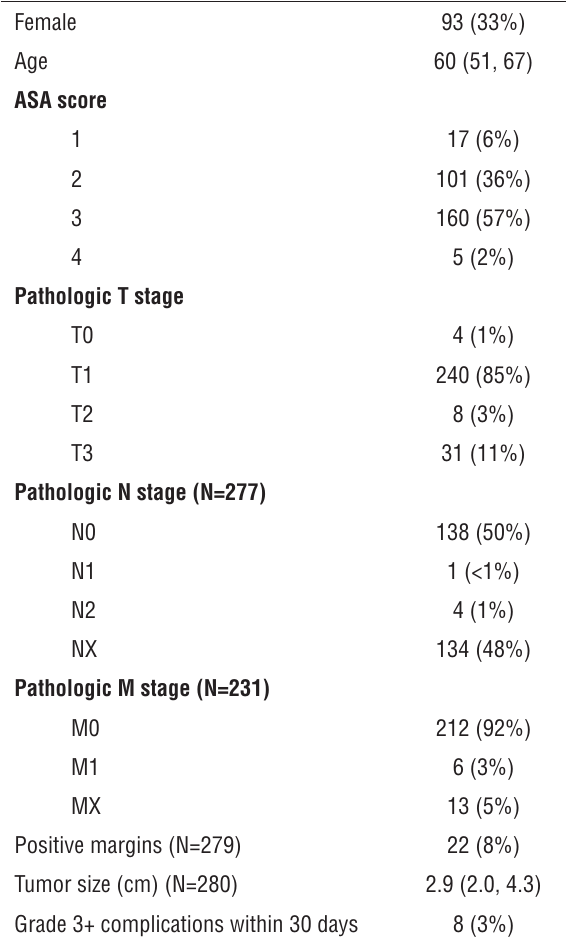
Table 1 - patient and tumor characteristics, n = 283. Data are reported as frequency (%) or median